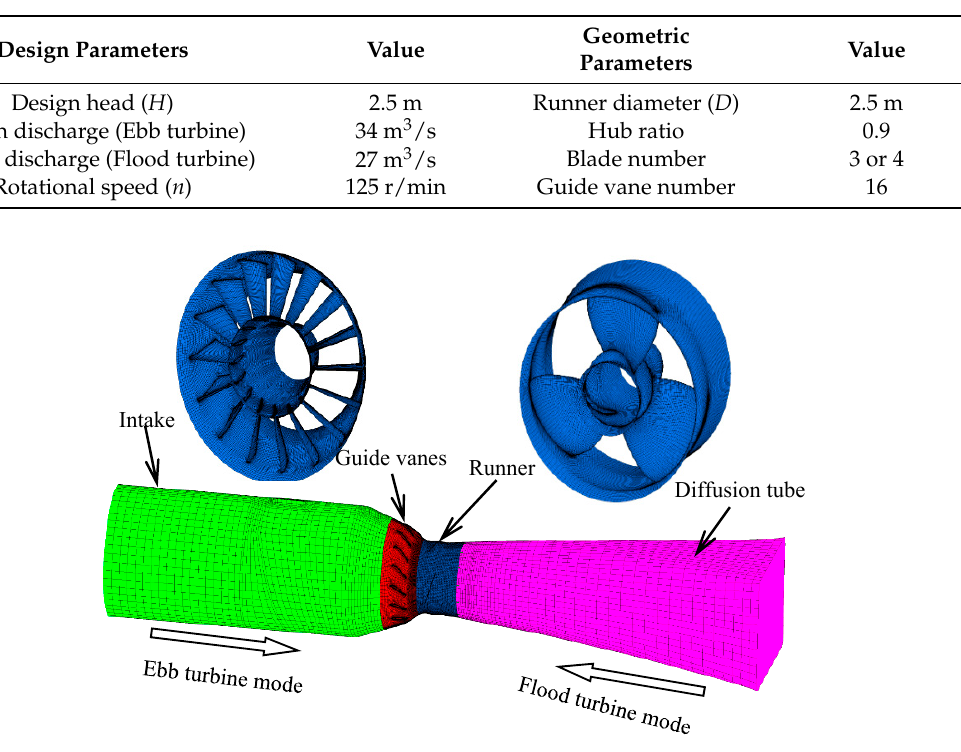
Figure 4. Mesh of the flow path.